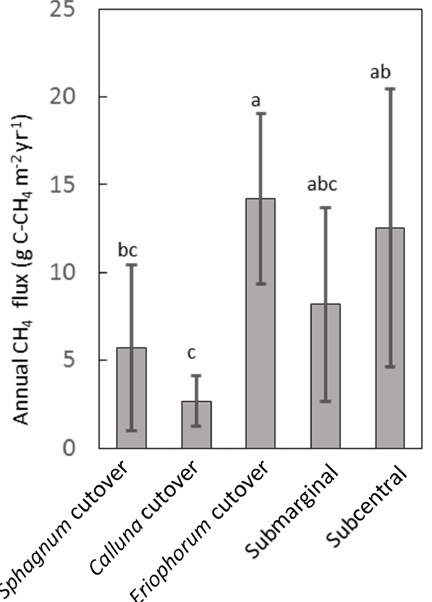
Figure 6. Annual CH 4 flux for each ecotype averaged over all col- lars in the ecotype. Shared letters represent no statistically signif- icant difference among ecotypes based on one-way ANOVA with Bonferroni honestly significant difference for pairwise compar- isons.